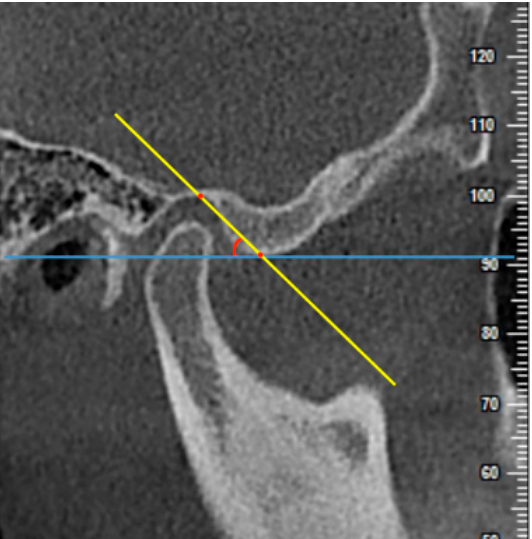
Figure 4. The measurement of AEI using the top-roof line method (AEI-TRL) on the central sagittal slice. The angle between the “top-roof line (the line connecting the crest point of the articular eminence and the roof of the glenoid fossa)” (yellow line) and a line parallel to the FH plane (blue line) was